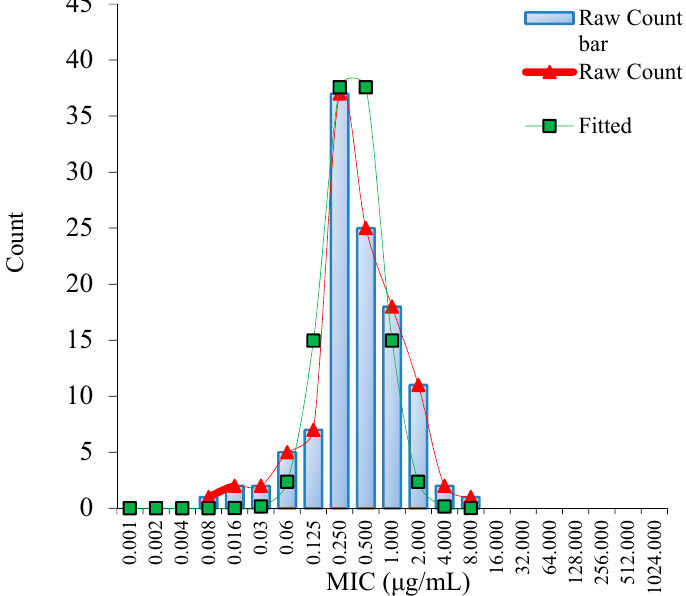
Figure 1. Nonlinear regression of MIC distribution of danofloxacin against MG ( n = 111). Note: “Raw Count” was the measured MICs of danofloxacin; “Fitted” was the simulated MICs of danofloxacin.